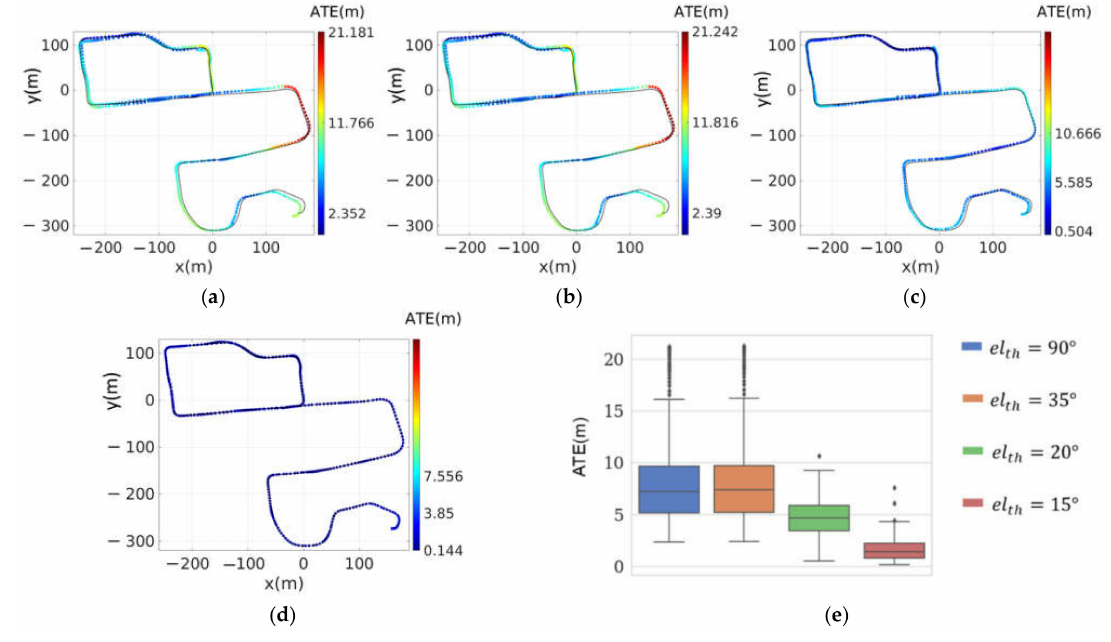
Figure 9. ( a – d ) plots the trajectory generated by pipelines with the thresholds el th for the GNSS-RTK availability assessment set as 90 ◦ , 35 ◦ , 20 ◦ and 15 ◦ respectively on urban-2. The black trajectory is the ground truth. The ATE of each estimated position is mapped on the trajectory referring to the color bar with the same scale on the right, on which the largest and the smallest tick label represent the maximum and the minimum ATE respectively while the middle one represents the midrange of them. ( e ) shows the boxplot of the ATE on the whole trajectory produced by the four